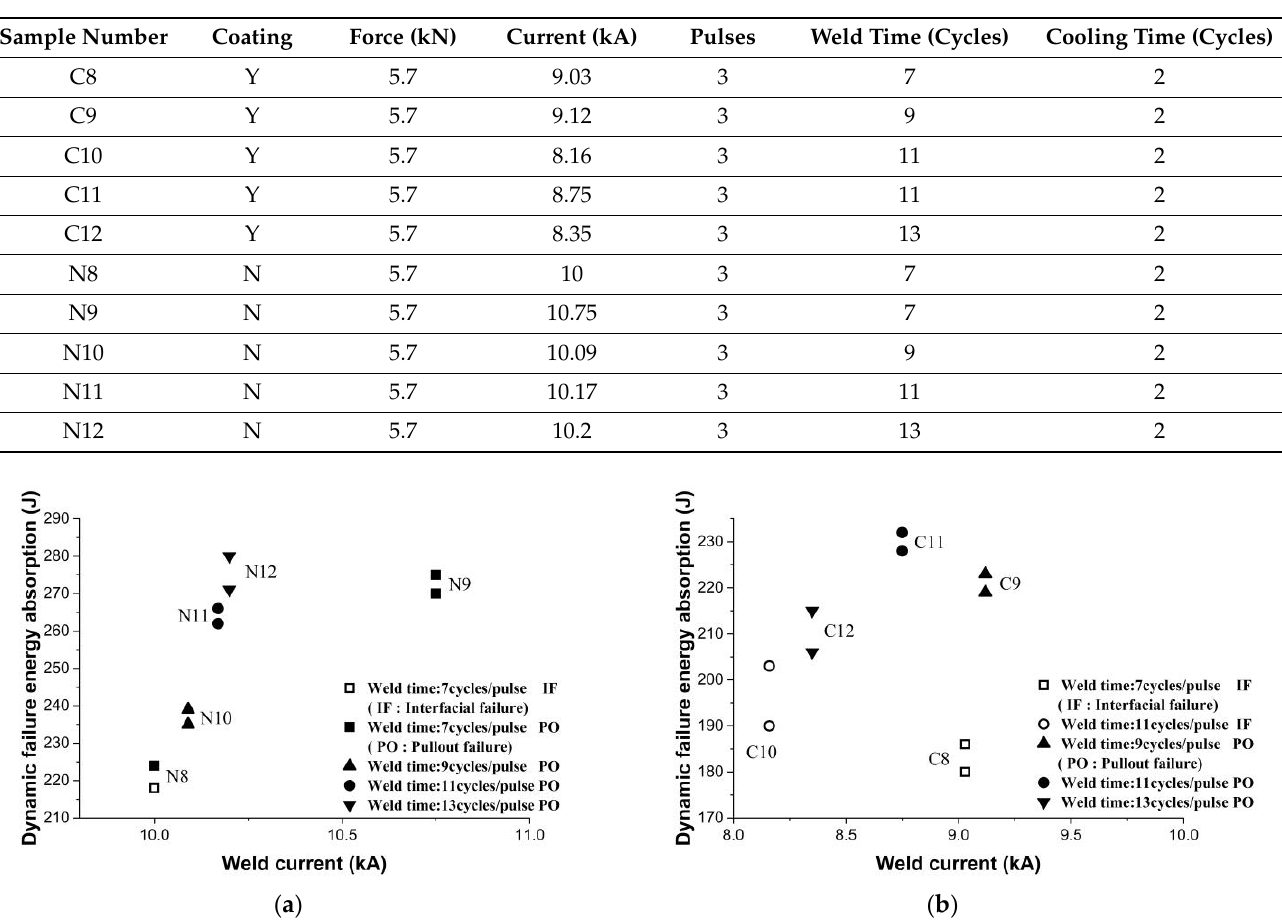
Figure 11. Dynamic failure energy absorption of welded joints during impact test versus welding parameters for ( a ) uncoated hot-Scheme 1500 and ( b ) Al-Si coated hot-stamped Usibor1500.